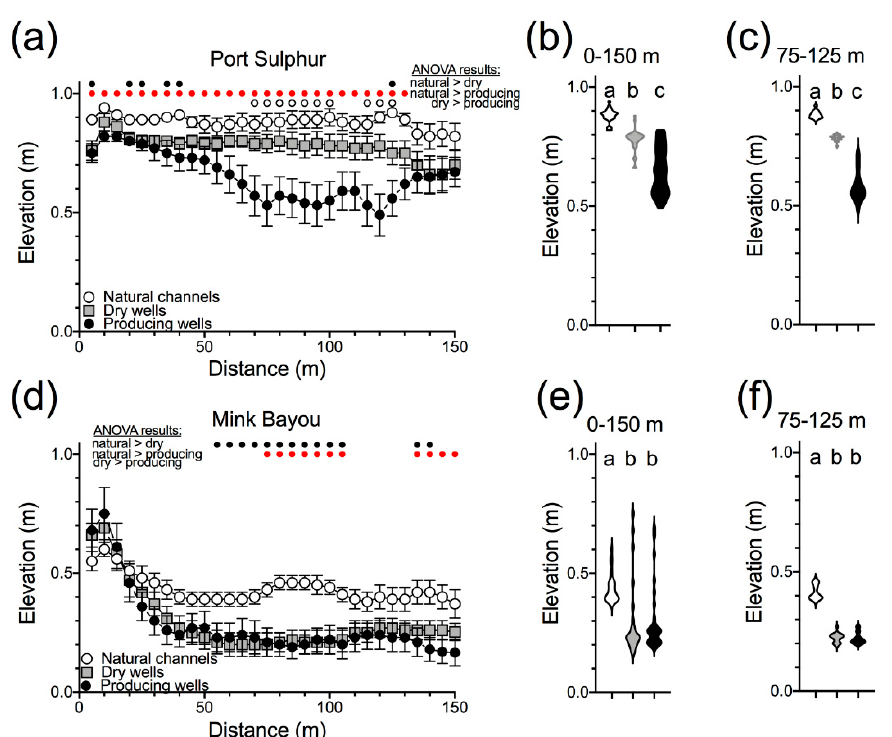
Figure 2. Marsh elevation along a 150-m transect for the three waterway categories at two locations. Significant differences between the 5-m elevation categories are indicated by the red and black dots at the top of ( a , d ). The violin plots to the right show the distribution of points (X axis) as proportional to the number of points in that Y value. The letters represent the result of an ANOVA testing for differences between each group. ( a ) Elevation (mean ± 1 SEM) and differences between the three site categories for each distance at Port Sulphur. ( b ) Violin plots of data distribution from 0 to 150 m in each of the three categories in ( a ). ( c ) Violin plots of data distribution from 75 to 125 m in each of the three categories in ( a ). ( d ) Elevation (mean ± 1 SEM) and differences between the three site categories for each distance at Mink Bayou. ( e ) Violin plots of data distribution from 0 to 150 m in each of the three categories in ( d ). ( f ) Violin plots of data distribution for 75 to 125 m in ( d ). The average elevation for Port Sulphur data from the 75- to 125-m zone ( µ ± 1 SEM) of the marshes with natural channels was 0.89 ± 0.01 m (n = 308), 0.78 ± 0.014 m (n =